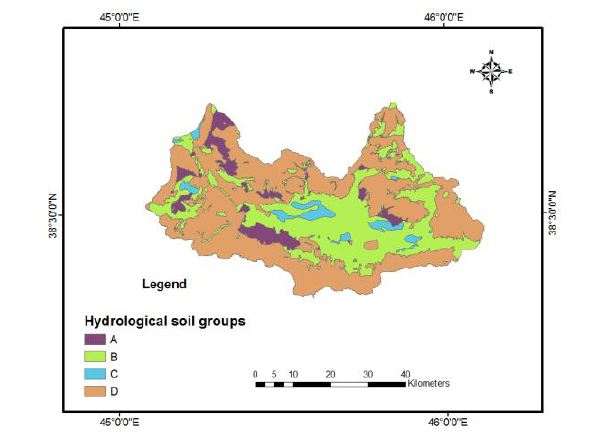
Figure 4. Hydrological soil groups of Zilberchai basin